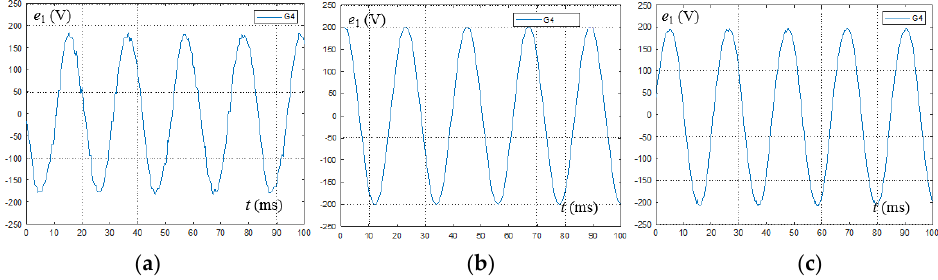
Figure 23. Waveform of induced EMF (phase 1) for the oblique model with cores G4: ( a ) numerical calculations FEM; ( b ) analytical calculations; ( c ) laboratory measurements.